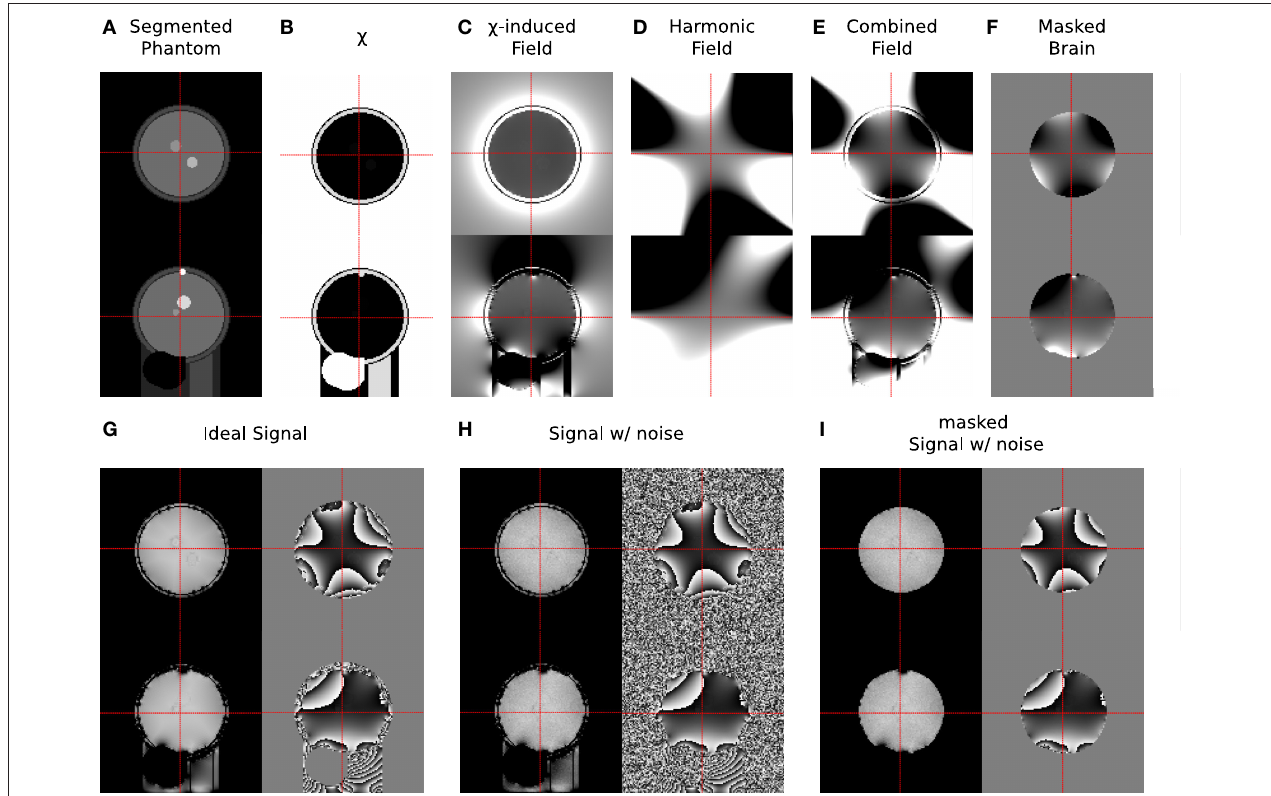
FIGURE 3 | Samples from all stages of the simulation process showing transverse (upper) and sagittal (lower) slices. (A) Segmented regions in phantom; (B) assigned magnetic susceptibility; (C) field shift caused by susceptibility distribution; (D) harmonic field distortions; (E) combined field distortions; (F) field distortions within brain mask; (G) ideal signal (magnitude/phase); (H) noise-biased signal (magnitude/phase); (I) noise-biased signal within m max (magnitude/phase). In each step the grey scale colour range was adapted to the contrast shown: (A) [0, 7]; (B) [ − 9.0, 0.36] ppm; (C–F) [ − 60, 60] Hz; (G–I) [0.5, 0.9] a.u. for magnitude and [ − π , π ] for phase,